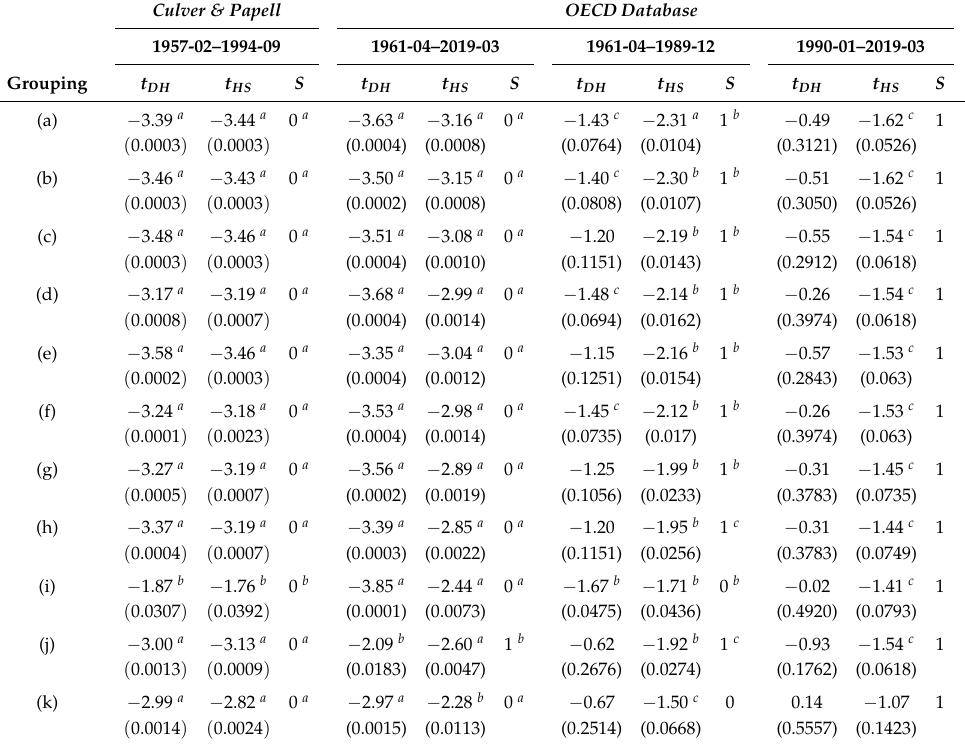
Table 2. Robust testing for unit roots in inflation panels of OECD countries. The groupings are as in Culver and Papell (1997): (a) Belgium, Canada, Germany, Spain, Finland, France, the United Kingdom, Italy, Japan, Luxemburg, the Netherlands, Norway, and the United States; (b) excludes France; (c) excludes Japan (d); excludes the Netherlands; (e) excludes France and Japan; (f) excludes France and the Netherlands; (g) excludes Japan and the Netherlands; (h) excludes France, Japan, and the Netherlands; (i) G7: Canada, France, Germany, Italy, Japan, the United Kingdom, and the United States; (j) the other six: Finland, Japan, Luxemburg, the Netherlands, Norway, and Spain; and (k) “Unit Root Seven”: Canada, Finland, Germany, Italy, Luxemburg, the Netherlands, and the United States. a Rejection at the 1% level. b Rejection at the 5% level. c Rejection at the 10% level. Entries for the S test are “1” when the underlying p -values imply mixed signals and are “0” for all else. Culver &